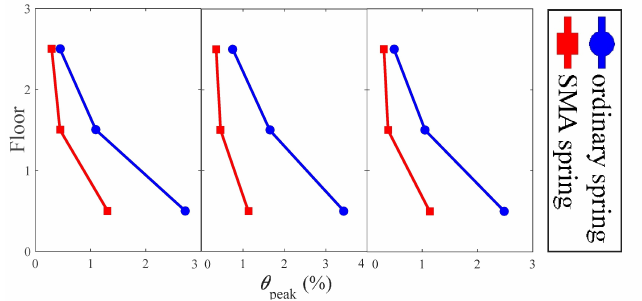
Figure 17. Peak interstory drift ratio of the superstructure under three different earthquake motions